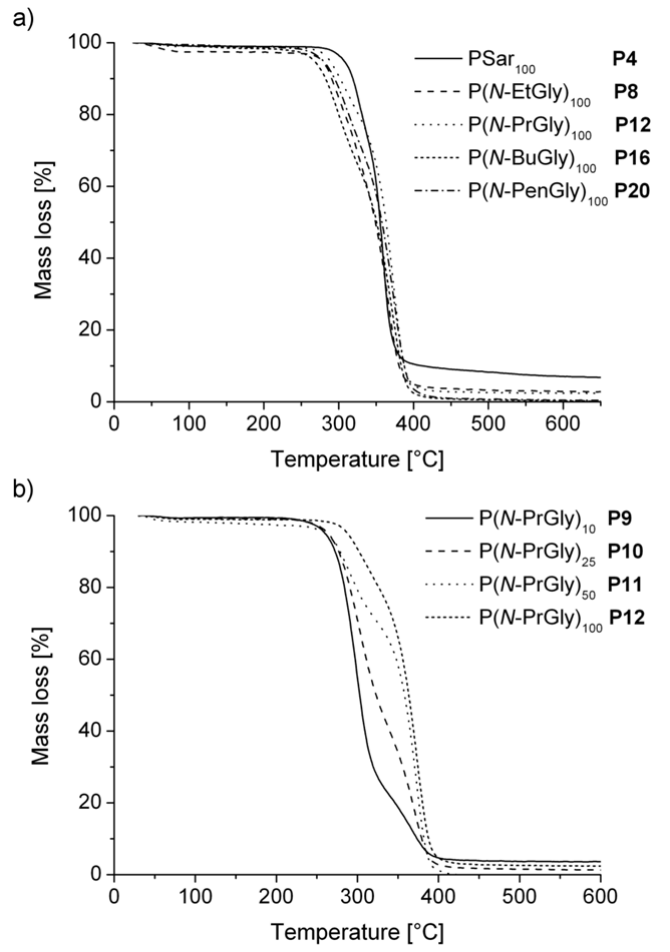
Figure 2. Comparison of TGA thermograms of different polypeptoid samples with ( a ) an increase in side chain length and ( b ) different degrees of